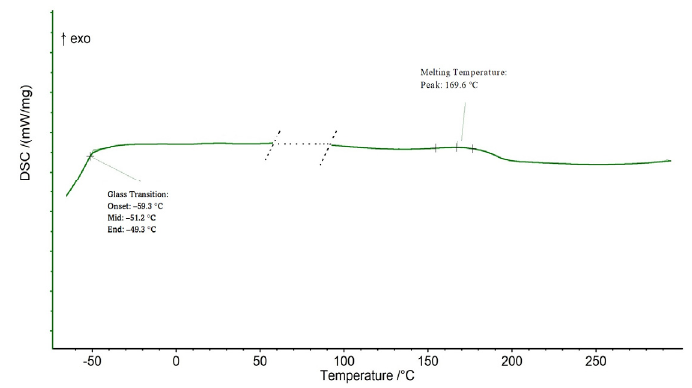
Figure 5. Polyester thermal performance (DSC).